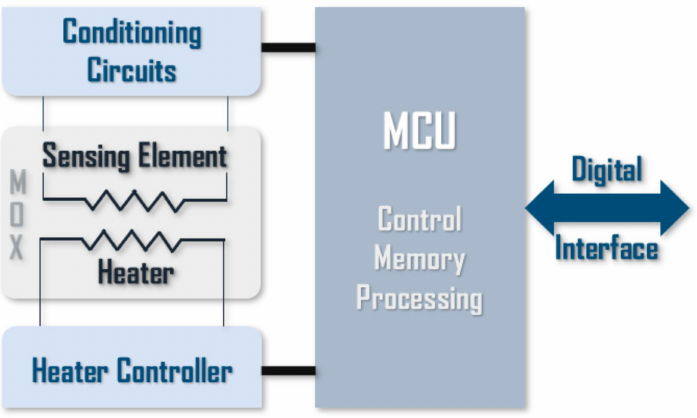
Figure 3. General block diagram of digital gas